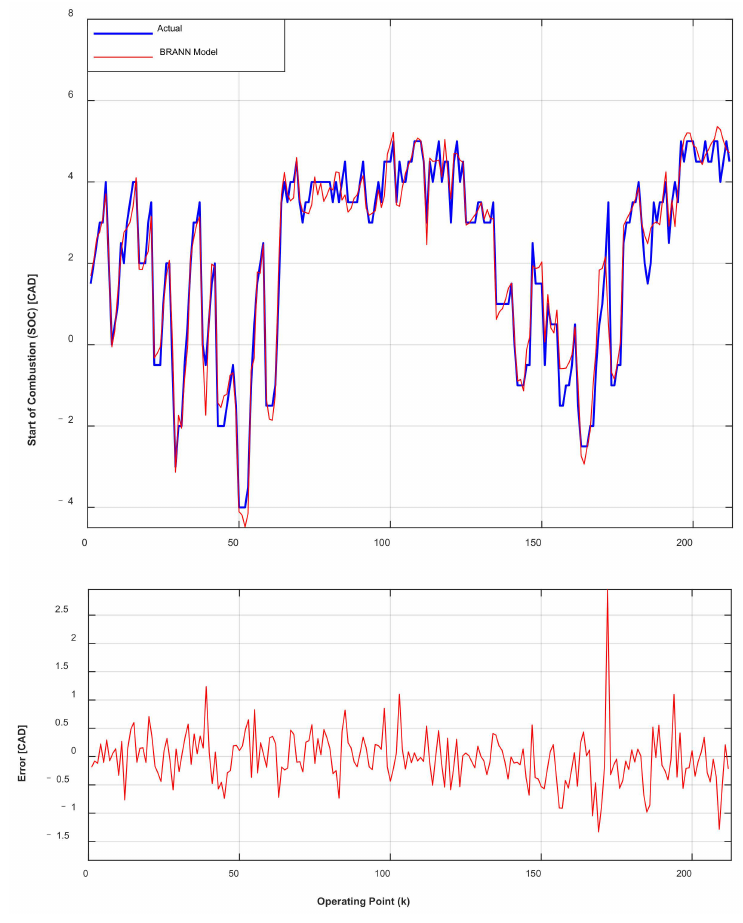
Figure 15. Comparison of the BRANN SOC model and the actual